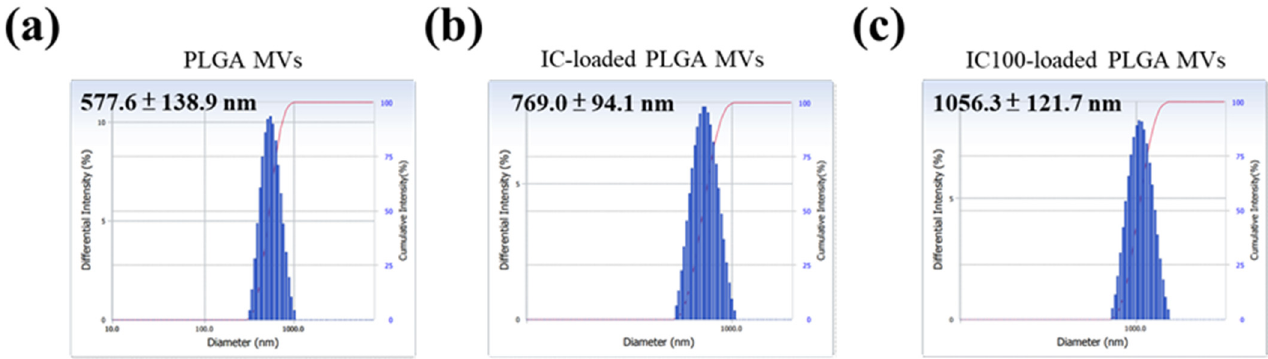
Figure 3. The hydrodynamic diameters of ( a ) PLGA MVs, ( b ) IC-loaded PLGA MVs, and ( c ) IC100-loaded PLGA MVs, as measured by DLS.